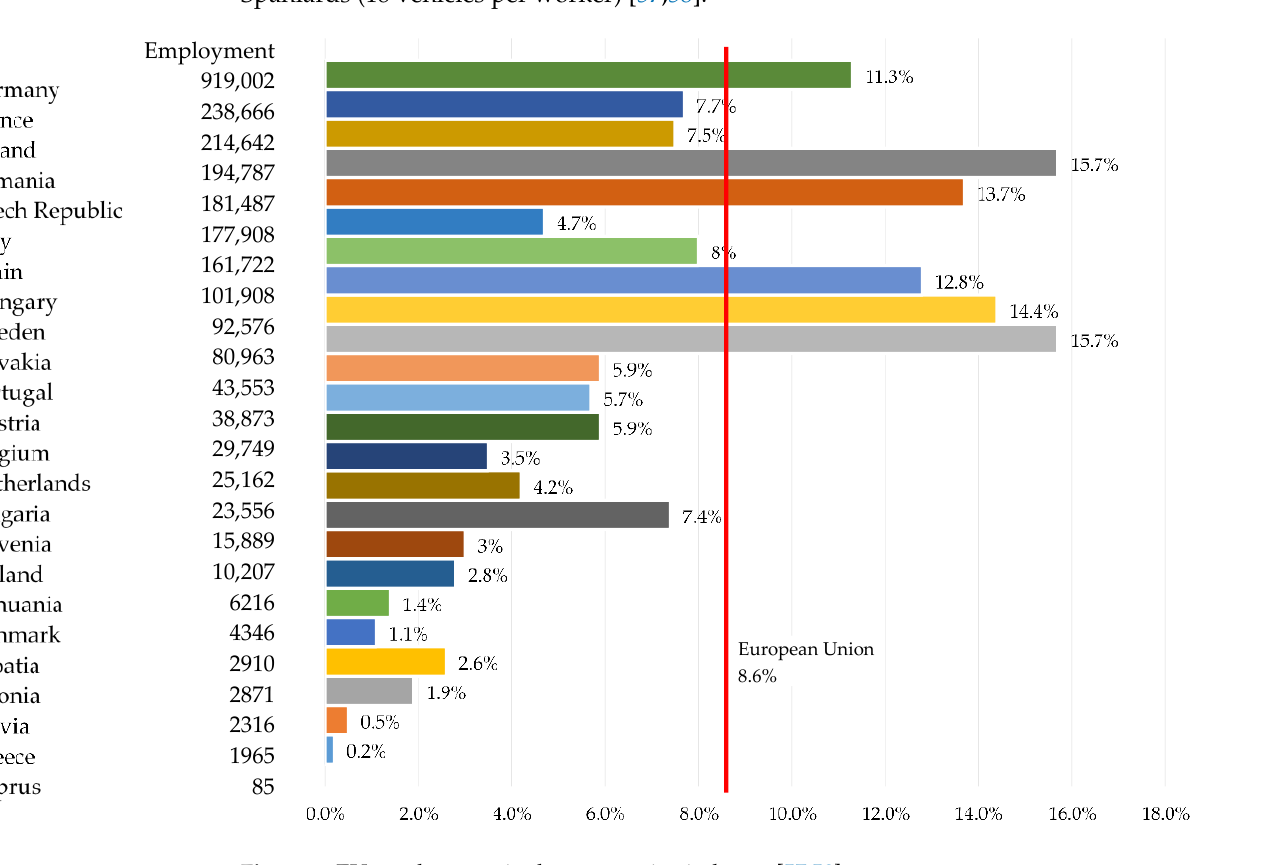
Figure 1. EU employment in the automotive industry [57,58].